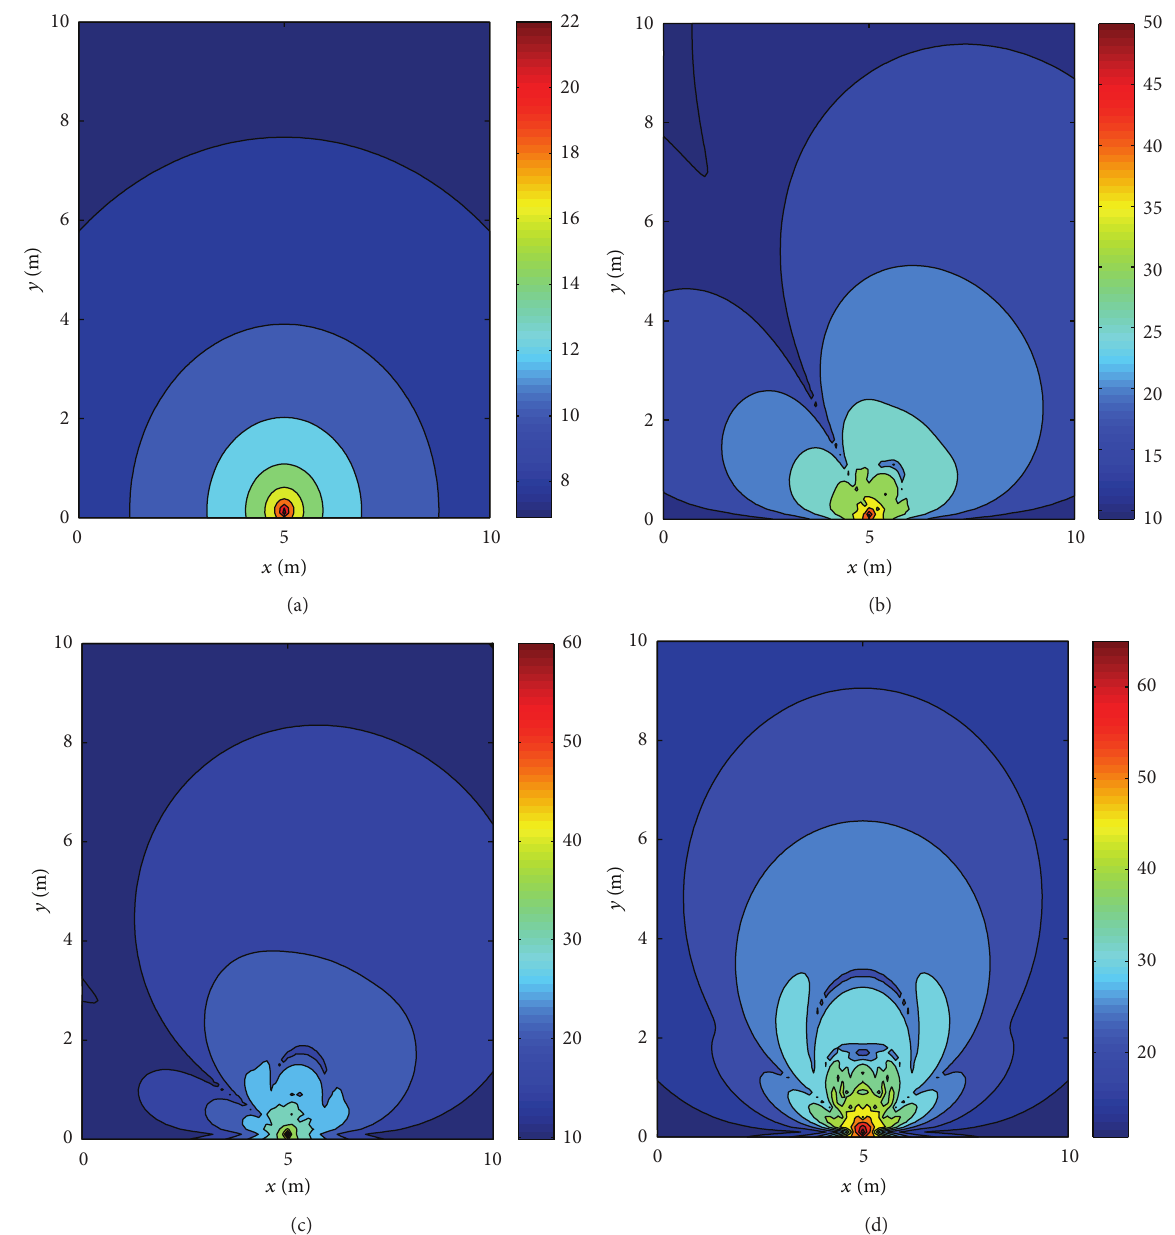
Figure 8: Indoor capacity (bit/s/Hz) achievable for different scenarios: (a) SIMO (b) 2 × 3 MIMO (c) central and right element in LOS, left element with one reflection (d) 3 × 3 MIMO in